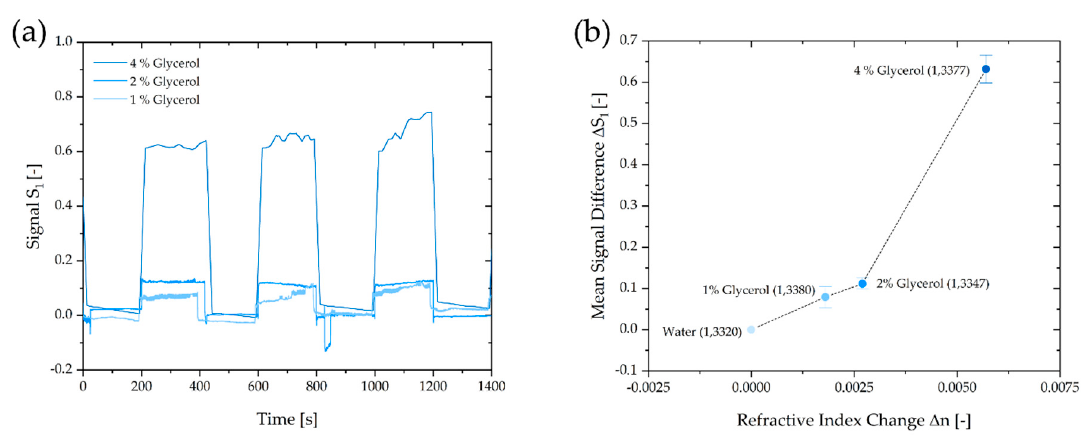
Figure 4. ( a ) Plot of the signal S 1 as a function of the measuring time. With the introduction of glycerol solution, a sudden change in S 1 is observed. As soon as distilled water enters the grating, the signal drops back to the initial value. ( b ) Plot of the mean signal difference Δ S 1 over the refractive index change Δ n .